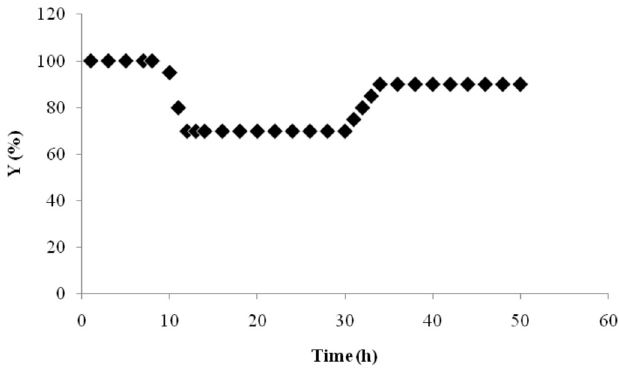
FIGURE 3 - Variation in conversion during continuous sucrose hydrolysis catalyzed by immobilized invertase for test 9: D = 0.4 h -1 (time interval: 0-10h); D = 0.8 h -1 (time interval: 11-30h) and D = 1.6 h -1 (time interval: